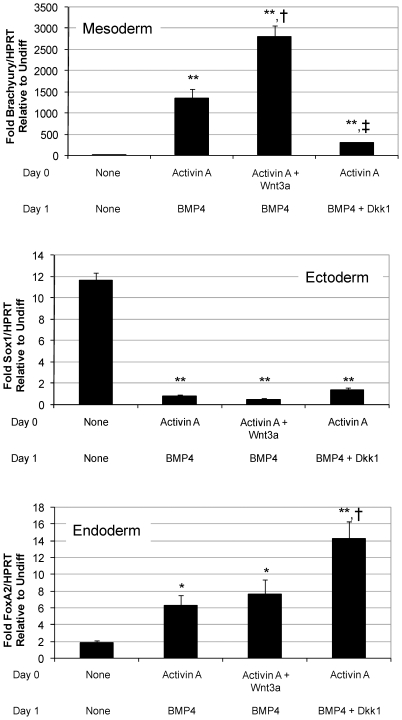
Wnt/β-catenin signaling enhances mesoderm induction.Quantitative RT-PCR analysis on day 2 of differentiation shows induction of Brachyury (mesoderm), FoxA2 (endoderm), and Sox1 (ectoderm). Brachyury expression induced by activin A/BMP4 was enhanced by Wnt3a and reduced by Dkk1. Data are presented as mean fold expression normalized to HPRT relative to undifferentiated cells + SEM. *p<0.05 relative to control, **p<0.01 relative to control, †p<0.05 relative to activin A/BMP4, ‡p<0.01 relative to activin A/BMP4.